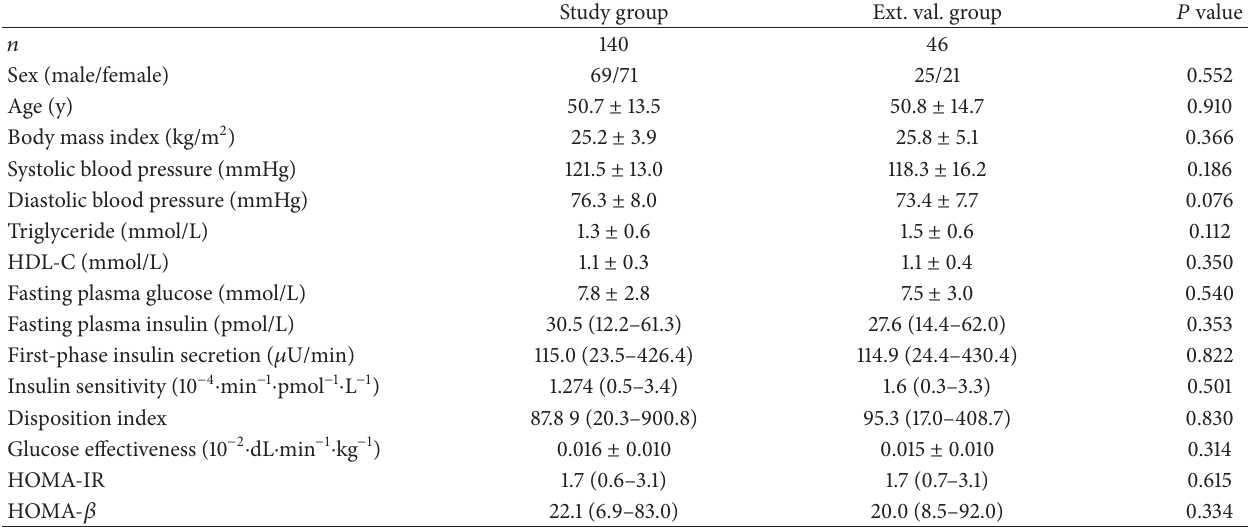
Table 1: Demographic data of the study and external validation groups.